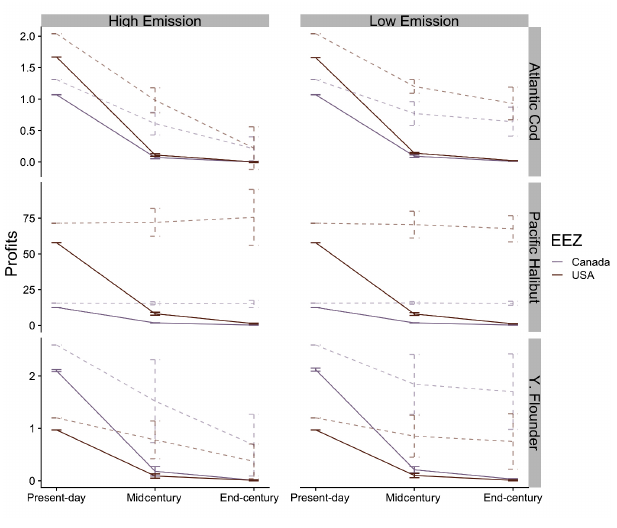
Fig. 2 . Average (± standard deviation) profits generated by fisheries in Canada and the United States under climate change. Midcentury represents the average of 2041-2060, and end-of- century is the average of 2080-2099. Values presented in constant US$2010 million. Solid line represents profits discounted to 5% and shaded dotted line represents nondiscounted profits.